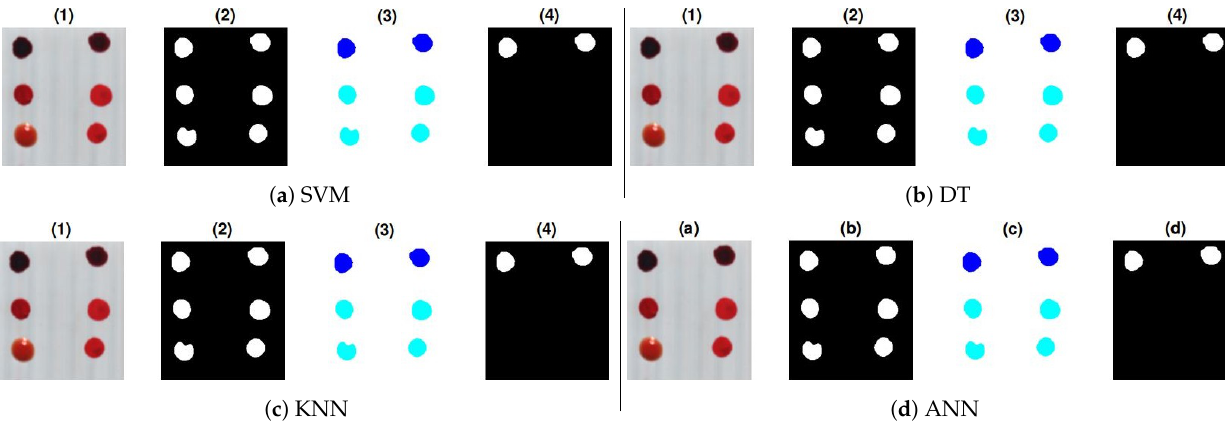
Figure 10. Prediction results of test samples on wall sheet: (1) True color image, (2) pre-processed image, (3)